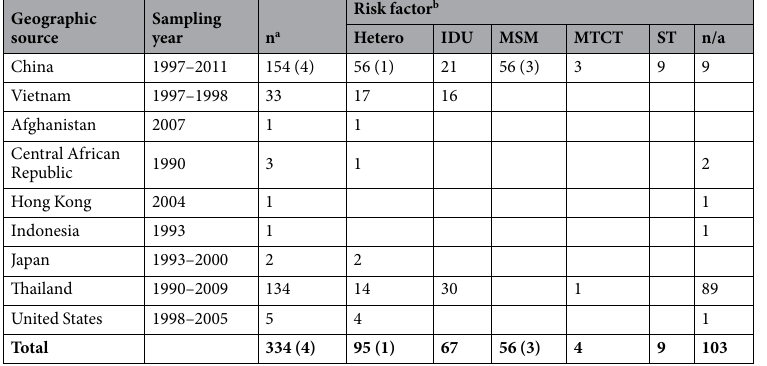
Table 1. Geographic source, sampling year, and risk factor for HIV-1 CRF01_AE strains analysed in the present study. a The numbers of HIV-1 CRF01_AE sequences newly reported in this study are shown in parentheses. b Risk group: Hetero, heterosexual; IDU, injecting drug user; MSM, men who have sex with men; MTCT, mother-to-child transmission; ST, sexual transmission, unspecified type; n/a, not